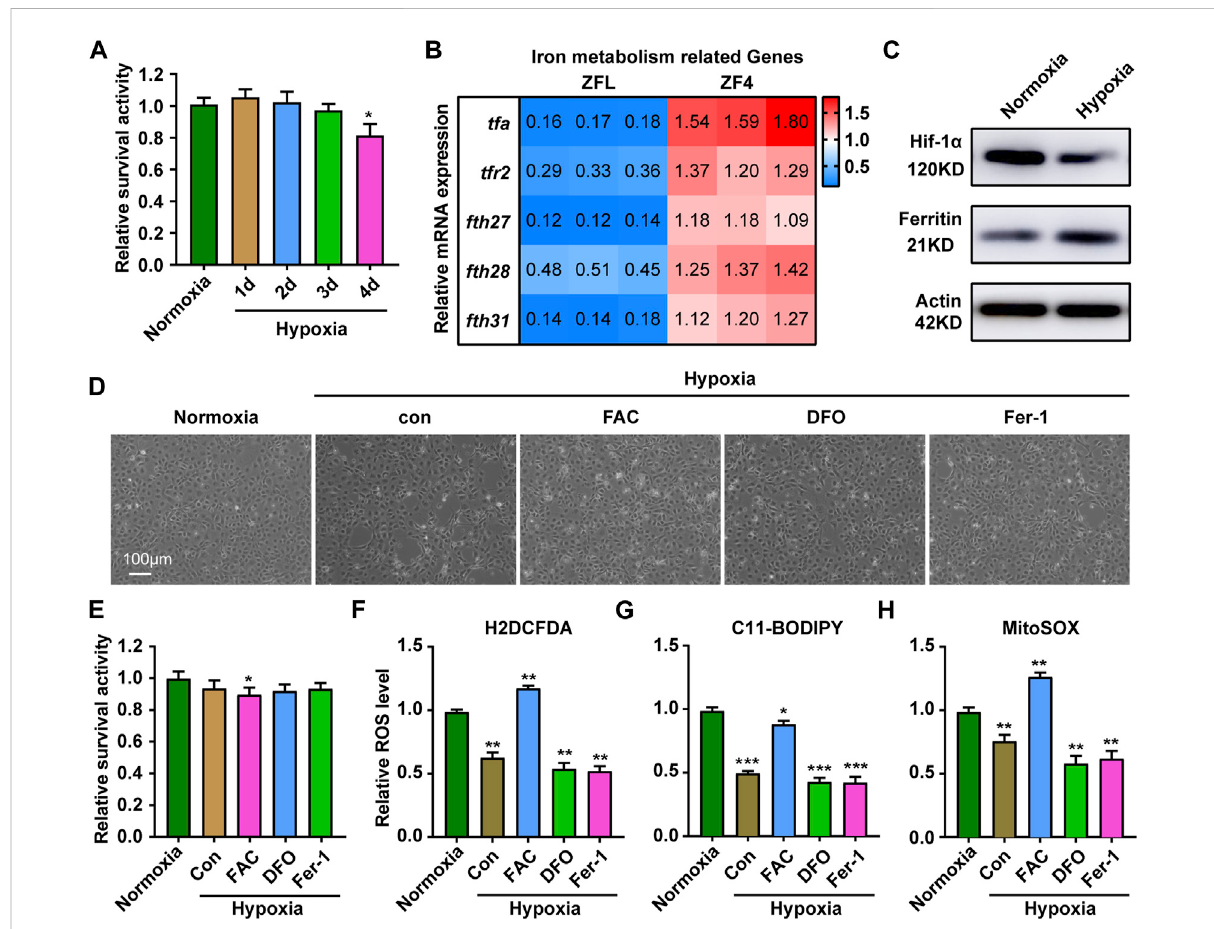
FIGURE 6 Response of ZF4 cells to hypoxic stress. (A) Cell Viability was analyzed with PrestoBlue ™ HS Cell Viability Regent under normoxia or hypoxia treated for 1, 2, 3 and 4 d. (B) The mRNA expression of iron absorption and storage gene in ZFL cells was quanti fi ed by real-time RT – PCR under normoxia and hypoxia for 3 days. (C) Western blot analysis of Hif-1 α and Ferritin expression in ZF4 cells cultured under normoxia and hypoxia for 3 days. (D) The microscopeanalysis ofmorphology changesinZF4cells undernormoxiaor hypoxiatreated withorwithoutFAC(2.5 mM), DFO (10 µM) and Fer-1 (2.5 µM) for 3 days. (E) Cell Viability was analyzed with PrestoBlue ™ HS Cell Viability Regent under normoxia or hypoxia treated withorwithoutFAC(2.5 mM),DFO(10 µM)andFer-1(2.5 µM). (F – H) AnalysisofchangesingeneralROS (F) ,mitochondrial-derivedROS (G) andlipid peroxidation (H) levels in cells with H2DCFDA, MitoSOX and C11-BODIPY probe under normoxia and hypoxia for 3 days. Cells under hypoxic stress wererescuedwithFAC(2.5 mM),DFO(10 µM)andFer-1(2.5 µM).Normoxiawasusedasacontrolgroupforsigni fi canceanalysis.Errorbars,mean± s.d., n = 3 (biological